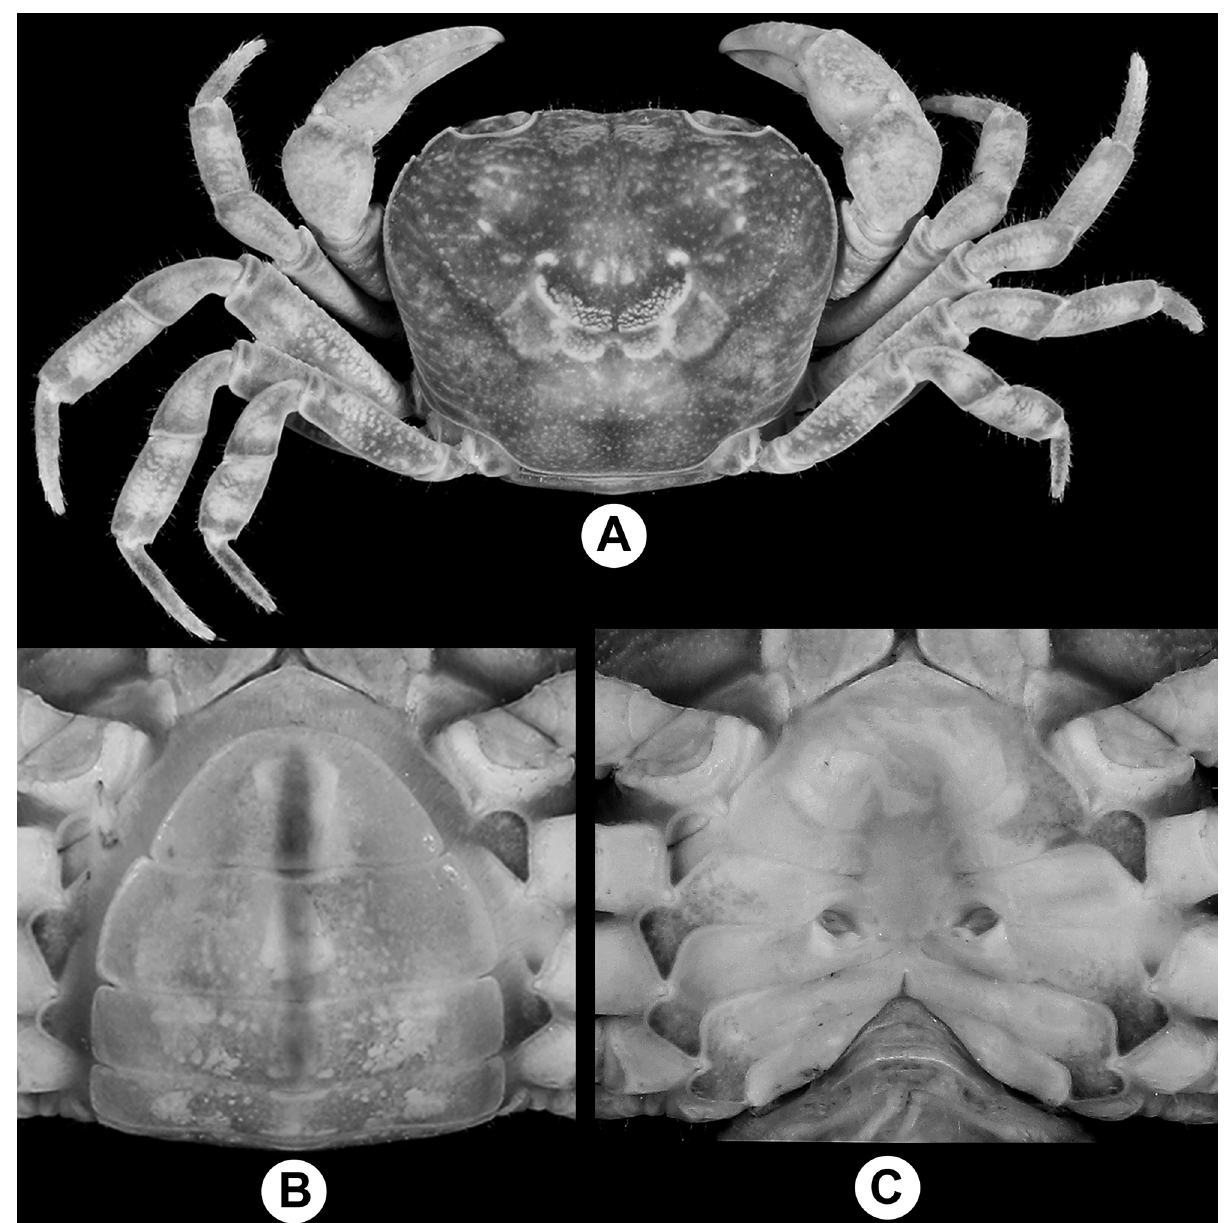
Figure 4. Abormon praecalvum sp. nov., paratype female (14.5 × 11.5 mm) (ZSI-WRC C.1942). A , overall dorsal view; B , pleonal somites 4–6 and telson; C , thoracic sternites showing